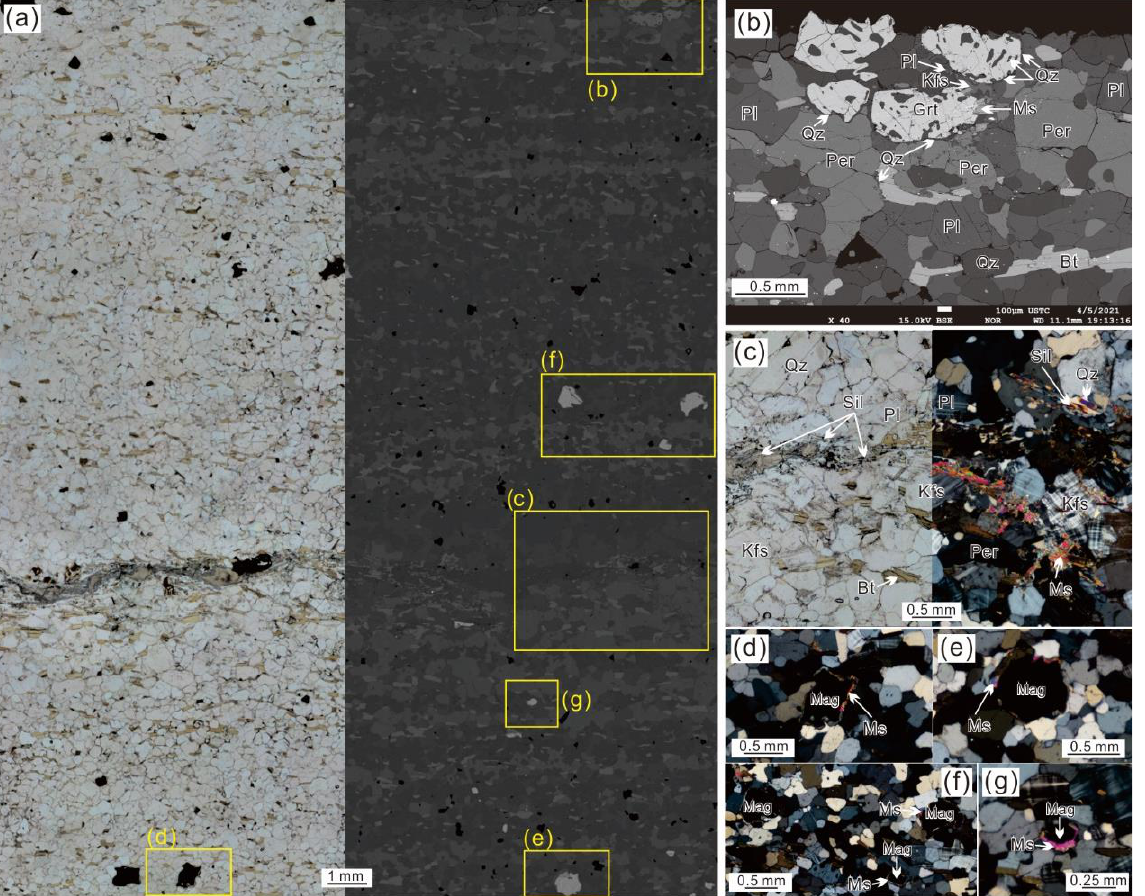
Figure 2. ( a ) Photomicrographs of the biotite two-feldspar gneiss using plane-polarized light ( left ) and back-scattered electron ( right ), showing the gneiss structure and compositional layers. ( b ) Garnet with embayed rims occurring in plagioclase-poor layer, and surrounded by tiny-grained feldspars, quartz and muscovite. ( c ) Sillimanite occurring in orientation with biotite. ( d–g ) Muscovite occurring around magnetite or biotite, suggesting melt crystallization.